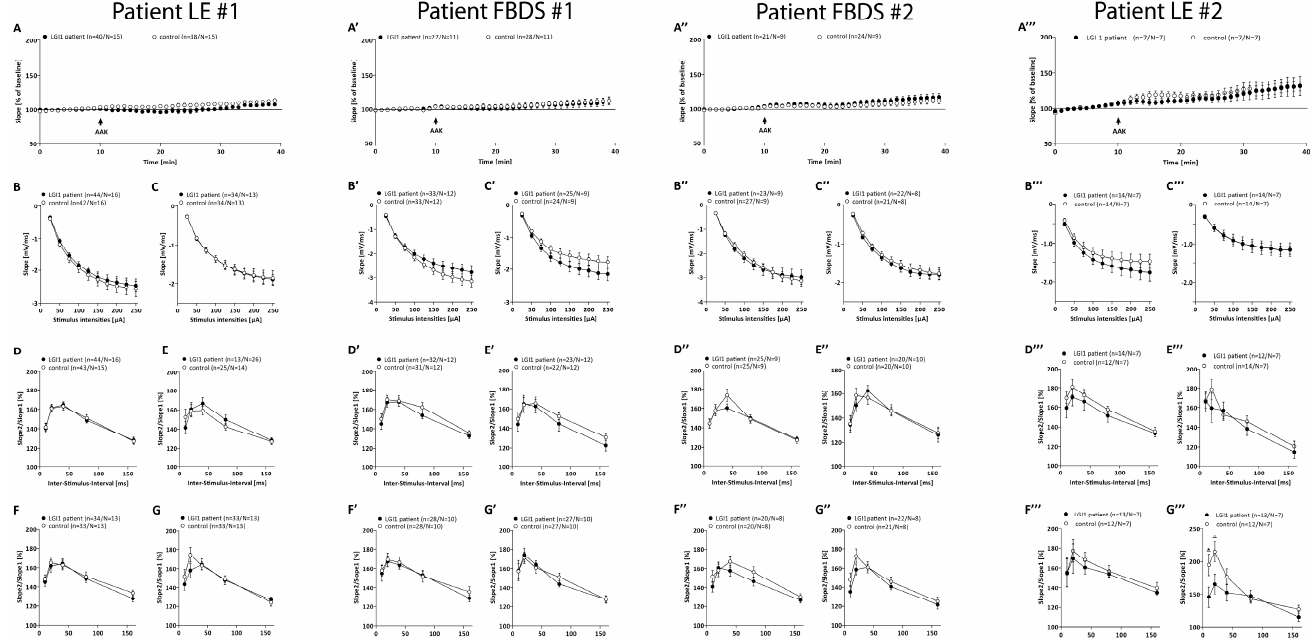
Figure 3. Additional electrophysiological recordings. Field excitatory postsynaptic potentials (fEPSPs) of acute hippocampal slices of C57Bl/6-GFP mice treated with control (open circles) or with LGI1 IgGs of each patient (black circles, frequency of 0.1 Hz). ( A – A”’ ) fEPSP recording with 40% of maximum slope for 10 min. Continuous wash-in of LGI1 IgGs did not alter the fEPSP signal. Input–Output curves revealed no differences in postsynaptic function after 1 h ( B – B”’ ) and additionally after 6